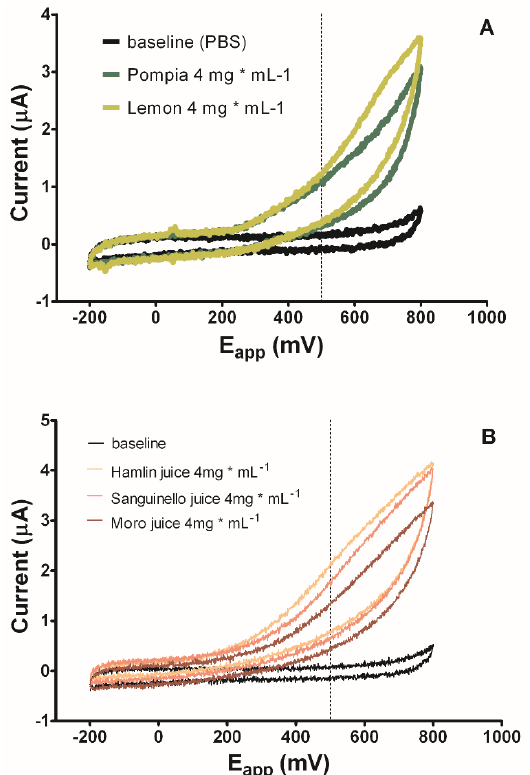
Figure 1. Cyclic voltammetry, with a scanned potential range (E app ) comprised between –200 mV and + 800 mV vs. carbon pseudoreference, in the absence (PBS black line) and in the presence of 4 mg mL − 1 of Pompia (green line) and lemon (yellow line) juices ( A ), and in the absence (PBS black line) and in the presence of 4 mg mL − 1 of Hamlin (yellow line), Sanguinello (orange line), and Moro (brown line) juices ( B